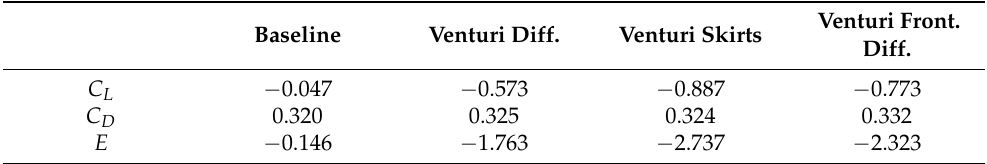
Venturi Front. Diff.